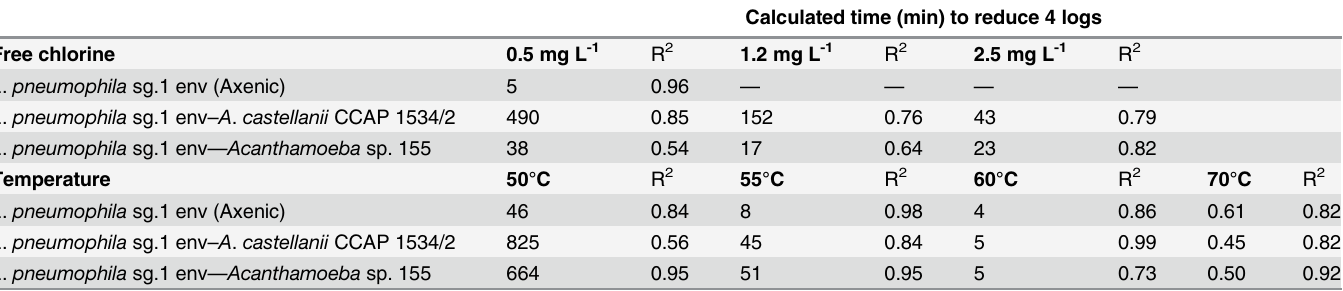
Table 4. Calculated time for a 4-log reduction of L . pneumophila sg. 1 env. associated with A . castellanii CCAP 1534/2 and Acanthamoeba sp. 155 after the exposure to different concentrations of free chlorine and temperatures. Inactivation kinetics adjusted to first-order models. R 2 values showed the robustness of the